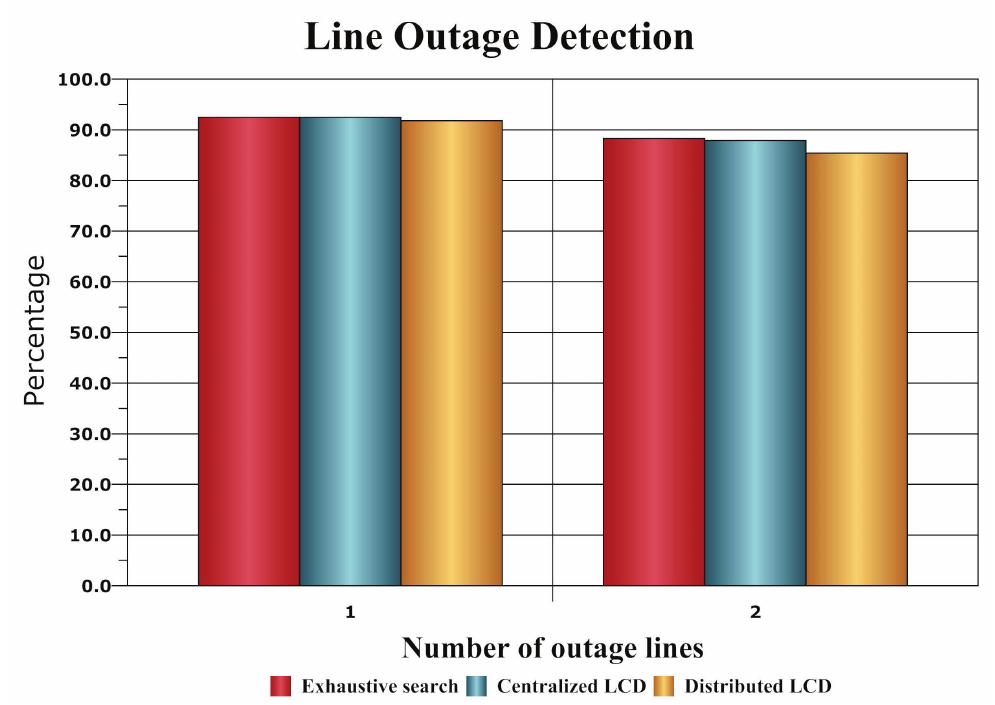
Figure 6. Comparison of detection performance for the IEEE 118-bus